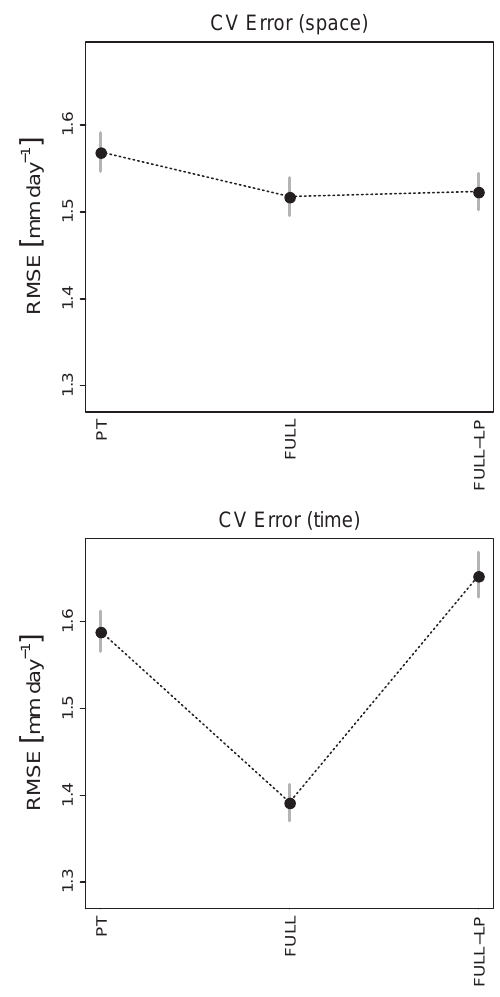
Figure 4. Model selection: RMSE of the three considered model setups (PT: precipitation and temperature forcing. FULL: full at- mospheric forcing. FULL-LP: full atmospheric forcing and land parameters; see Sect. 3.1). RMSE is estimated for both the cross validation in space and the cross validation in time (see Sect.